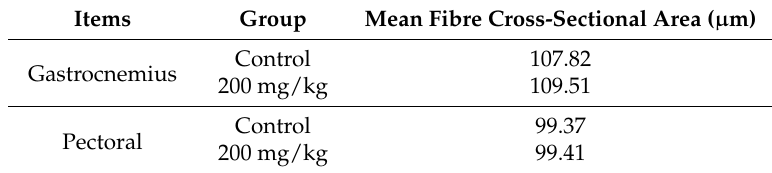
Table 5. Effect of L -theanine on histomorphometry of pectoral and gastrocnemius muscles. Items